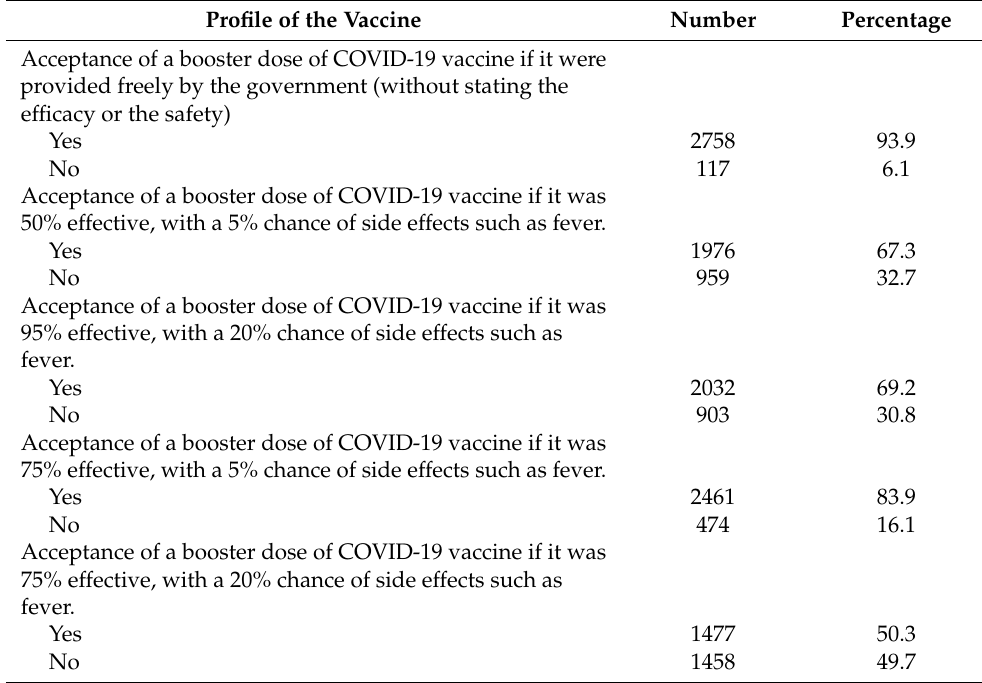
Table 3. Acceptance of the COVID-19 vaccine booster dose ( n = 2935). Profile of the